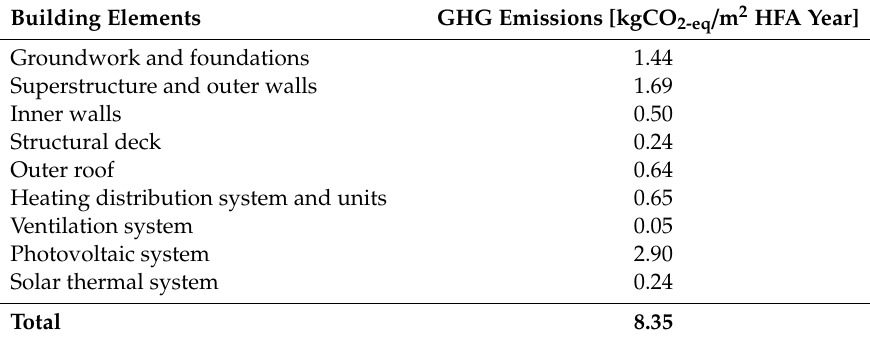
Table 5. Building elements of the ZEB Base Case included in the LCA calculation